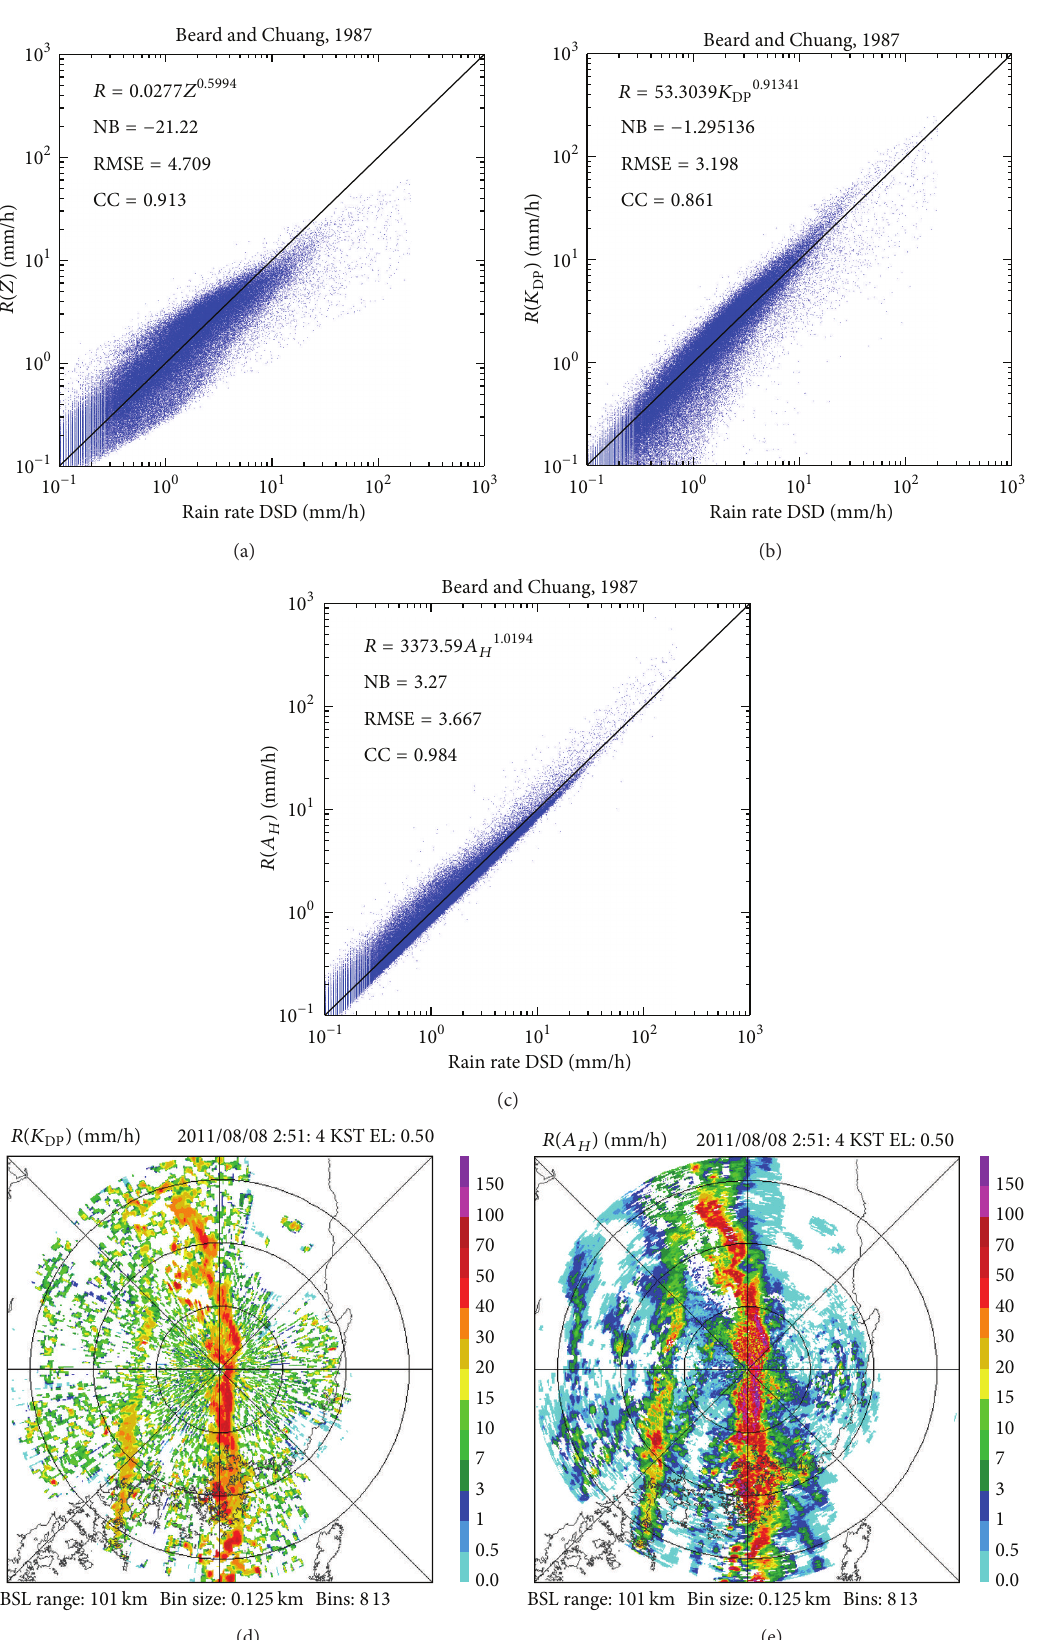
Figure 8: The scatter plot of (a) 𝑅(𝑍) , (b) 𝑅(𝐾 DP ) , and (c) 𝑅(𝐴 𝐻 ) with statistics and the rainfall distribution of 𝑅(𝐾 DP ) and 𝑅(𝐴 𝐻 ) at 0251 KST on the 8th of August in